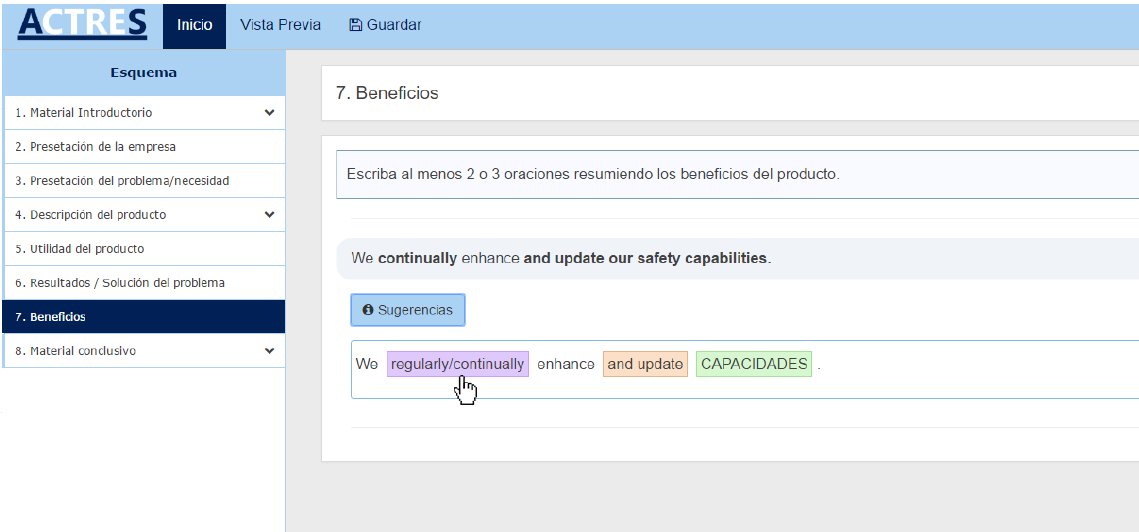
Figure 6. Completing and editing the model line selected with O-WEAA’s Writing Assistant Interface